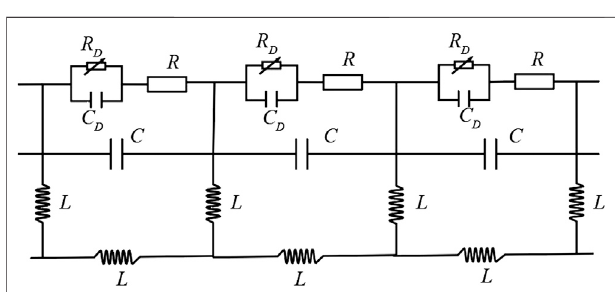
FIGURE 2 | Equivalent circuit model of the active high impedance